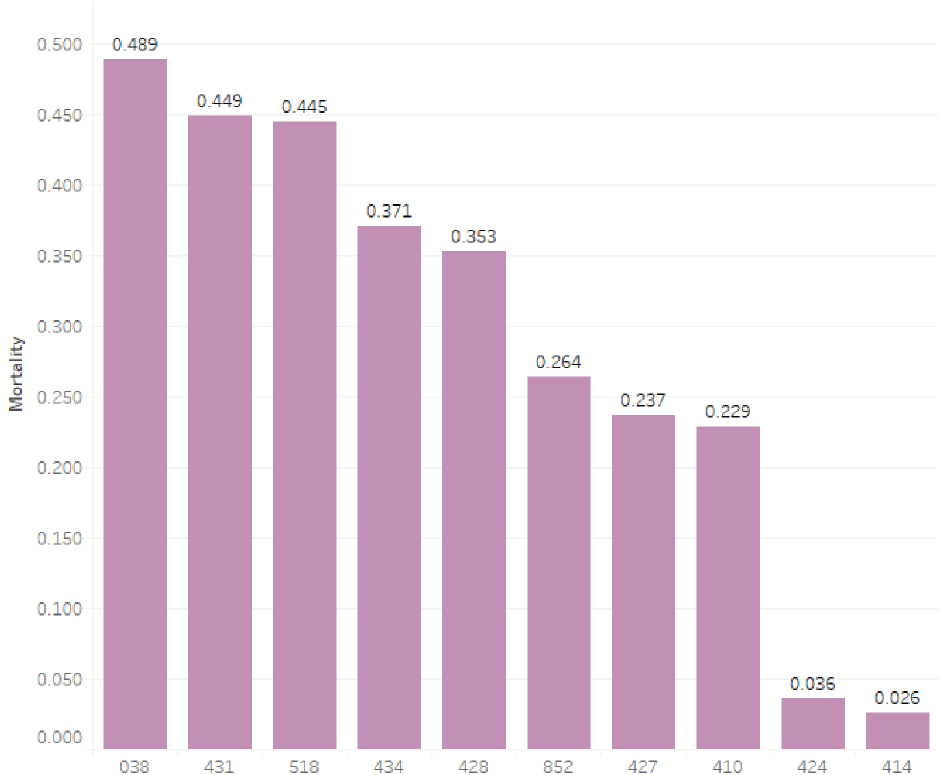
Fig 6. Mortality of ten diseases with the largest number of patients (all dead patients: death in-hospital + 90-day of death after discharge).